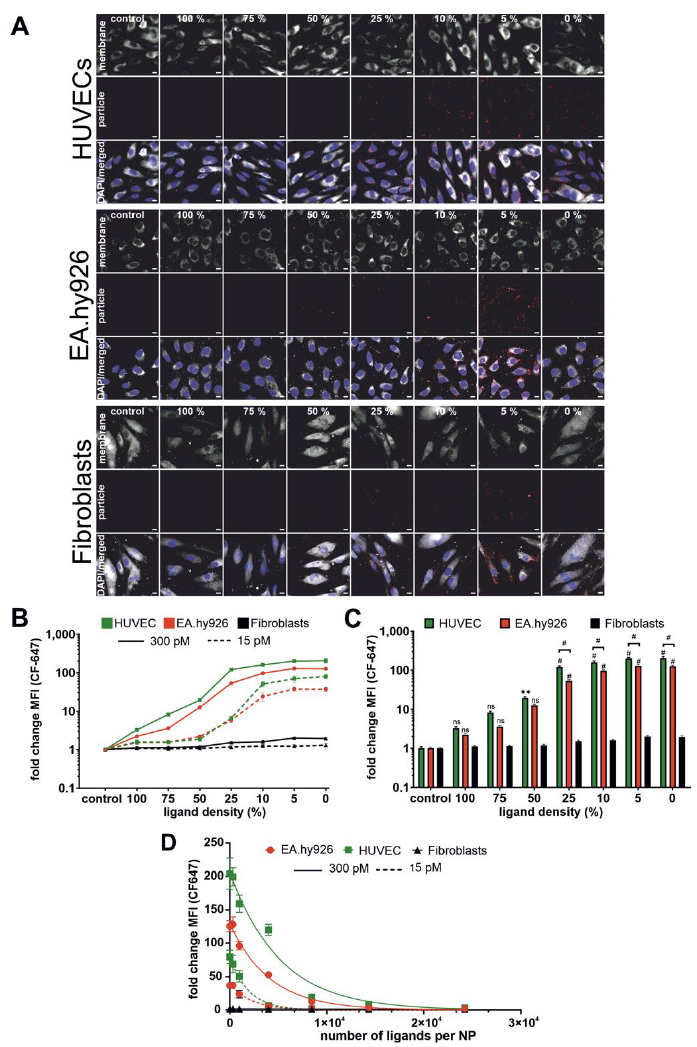
Figure 4. Interaction of Angpt-1 mimetic NPs with HUVECs, EA.hy926 cells and fibroblasts. ( A ) Rep- resentative fluorescence microscopy images of cells that were incubated with NPs (300 pM) for 2 h. NPs were labeled with CF 647 and are shown in red. The ligand density ranged from 100 to 0%. Plasma membrane was stained with CellMask and is shown in white. After incubation with NPs, cells were washed with DPBS, fixed and nuclei were stained with 4 (cid:48) ,6-diamidino-2-phenylindole (DAPI) and are shown in blue. With decreasing ligand density, increasing levels of NP-associated fluorescence were detected. ( B ) Corresponding flow cytometry analysis of NP–cell interaction. Cells were incubated with NPs at a concentration of either 300 or 15 pM. Presented is the fold change of cell-associated mean fluorescence intensity (MFI) of NPs compared to untreated control cells. NPs were again labeled with CF 647. Angpt-1 mimetic NPs showed a substantially increased cell interaction with decreasing ligand density. The interaction was higher for HUVECs and EA.hy926 cells than for fibroblasts. ( C ) Statistical analysis of cells treated with a NP concentration of 300 pM. ( D ) Correlation between NP–cell interaction and number of ligands per NP. NP–cell interaction of HUVECs and EA.hy926 cells correlated with the number of ligands in a kind of exponential manner. Data were fitted using a one phase exponential equation model. Results are presented as mean ± SD of at least n = 3 measurements. ** p < 0.01, # p < 0.0001, ns: not